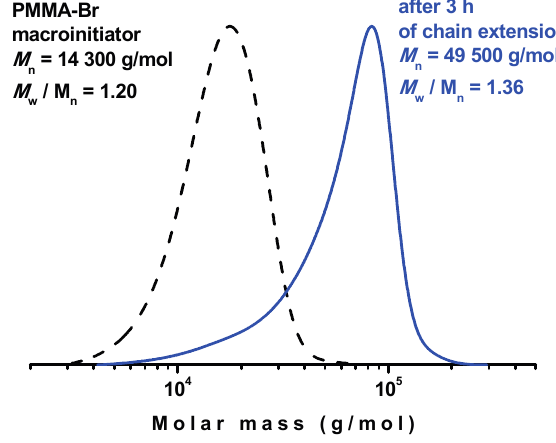
Figure 5. GPC traces from chain extension of PMMA-Br with MMA; ( dash black curve ) PMMA-Br macroinitiator and ( solid blue curve ) chain-extended PMMA after 73% conversion of MMA. The preparation of the PMMA-Br macroinitiator and the chain extension were performed by photoRDRP using a CuSO 4 ·5H 2 O/TPMA catalyst complex. Experimental conditions: preparation of PMMA-Br, MMA/BPN/Cu II /TPMA = 200/1/0.04/0.16, DMSO (25 vol%); chain extension: MMA/PMMA–Br/Cu II /TPMA = 600/1/0.12/0.48, DMSO (50 vol%); in both polymerizations: [MMA] = 7.5 M, T = 35 °C, irradiation at λ > 350